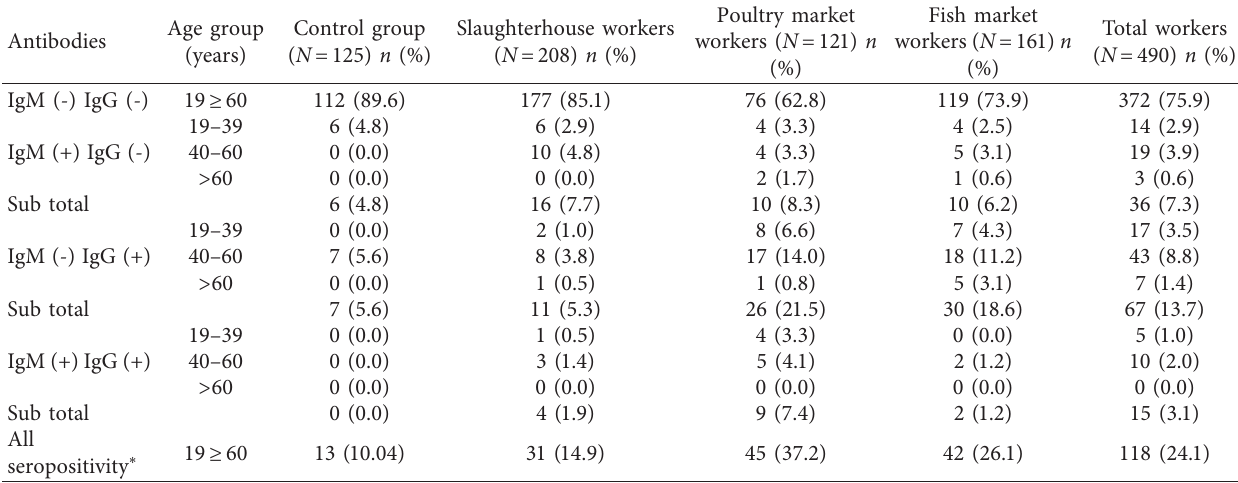
Table 2: Leptospiral seropositivity rates according to antibodies (IgM/IgG), age groups and occupational risk in Casablanca (Morocco).